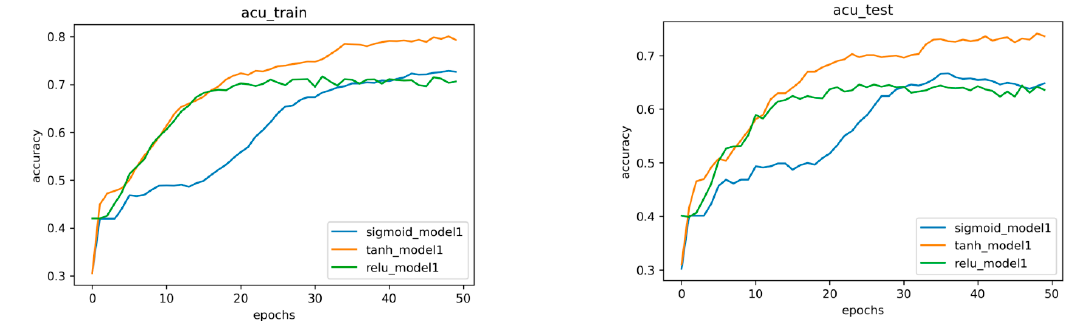
Figure 8. Comparison of the accuracy of different activation function models.